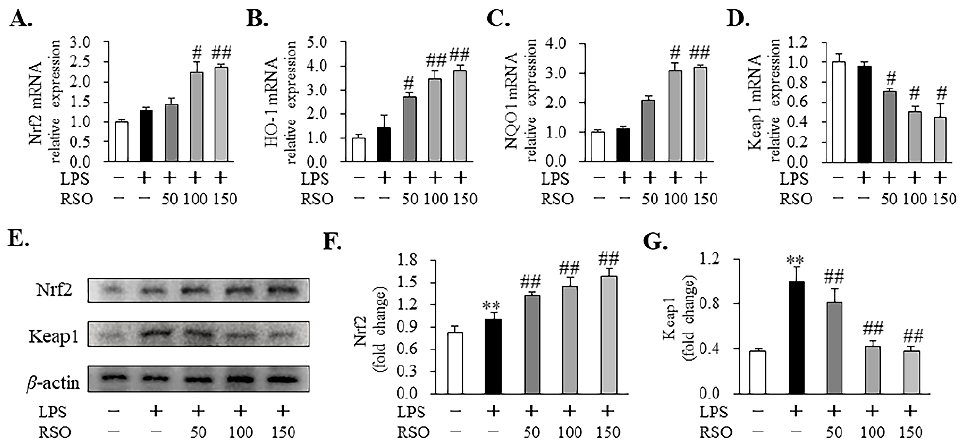
Figure 3. Effect of RSO on Nrf2-Keap1 pathway of LPS-induced RAW 264.7 cells. Relative mRNA expression of Nrf2 ( A ), HO-1 ( B ), NQO1 ( C ), and Keap1 ( D ) genes normalized to β -actin and expressed as fold change of the control group, n = 3. ( E ) The protein levels of Nrf2 and Keap1 were analyzed by immunoblotting with β -actin as the internal reference protein for normalization, n = 3. Relative protein expression of Nrf2 ( F ) and Keap1 ( G ) were expressed as fold change of the LPS-induced group. ** p < 0.01 vs control group; # p < 0.05, ## p < 0.01 vs LPS-induced group.